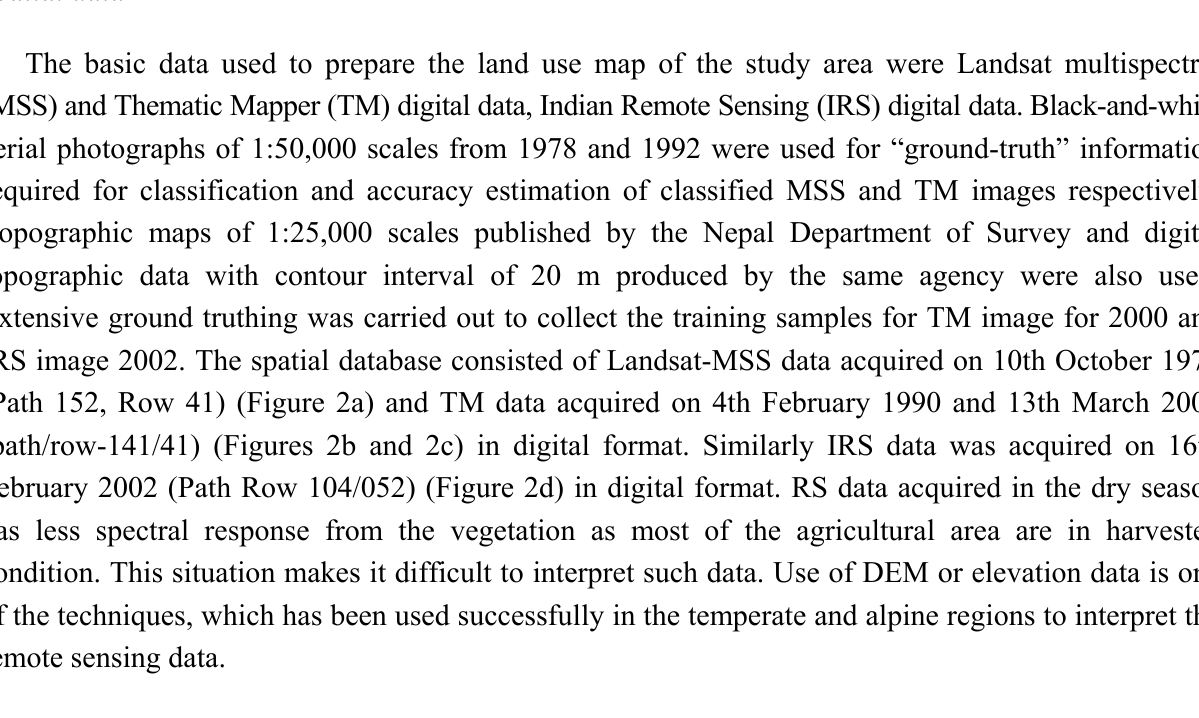
Figure 2. Satellite images over Galaudu watershed (a) Landsat MSS 1976 (b) Landsat TM 1990 (c) Landsat TM 2000 (d) IRS LISS III